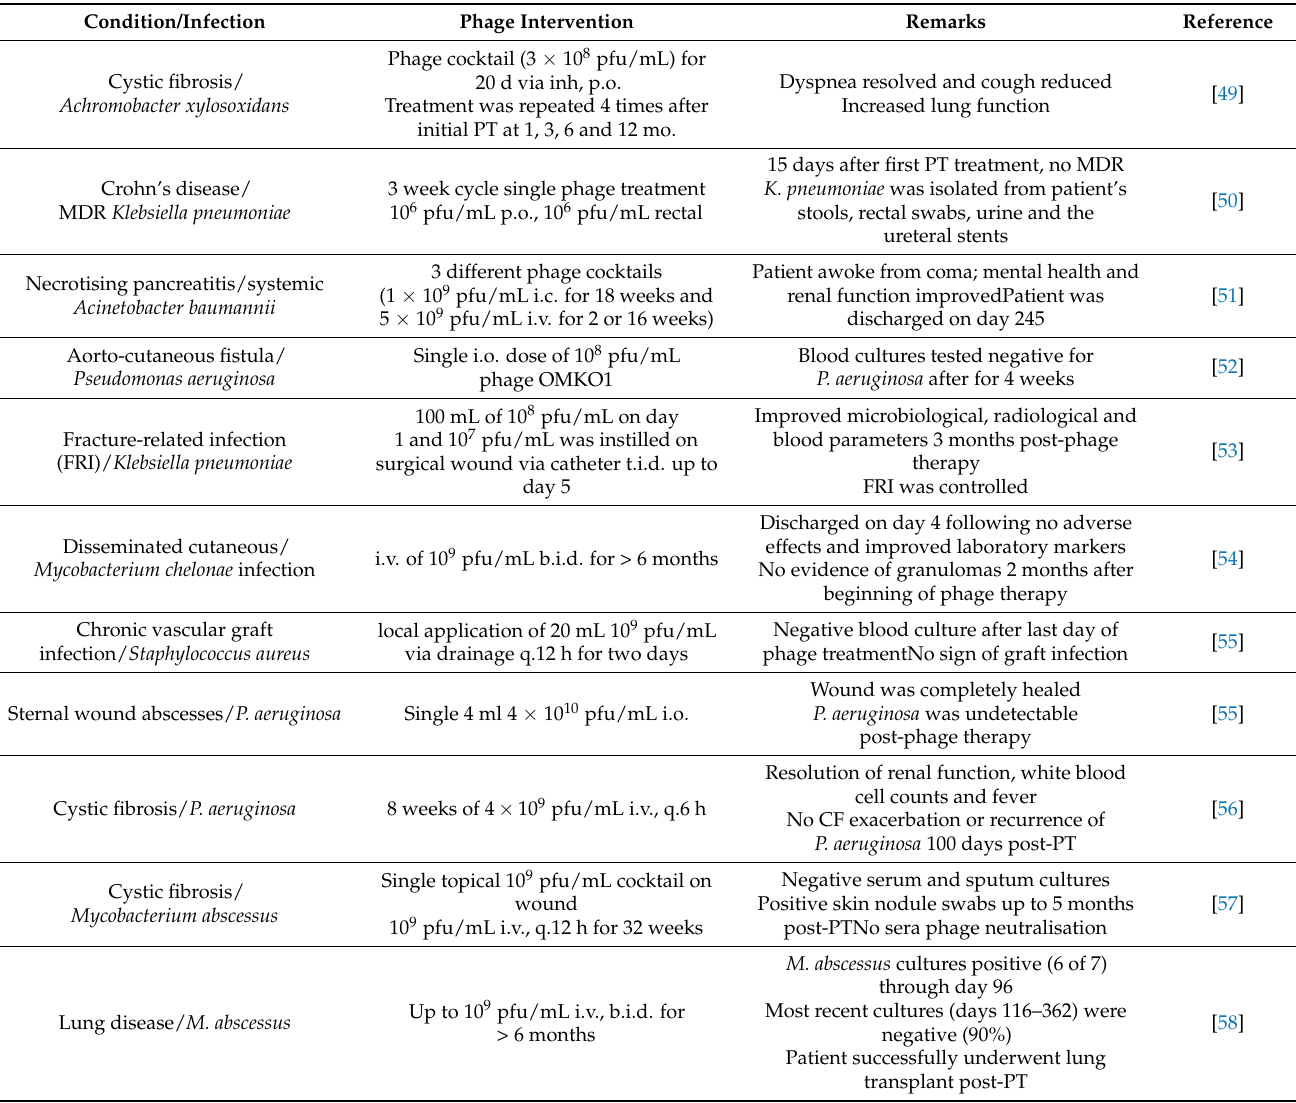
Table 2. Some applications of phages in human infections